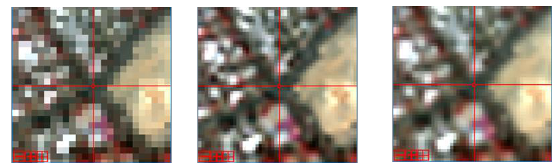
Figure 3. Enlarged Version of Patches in NN Resampled Image and Super-Resolved